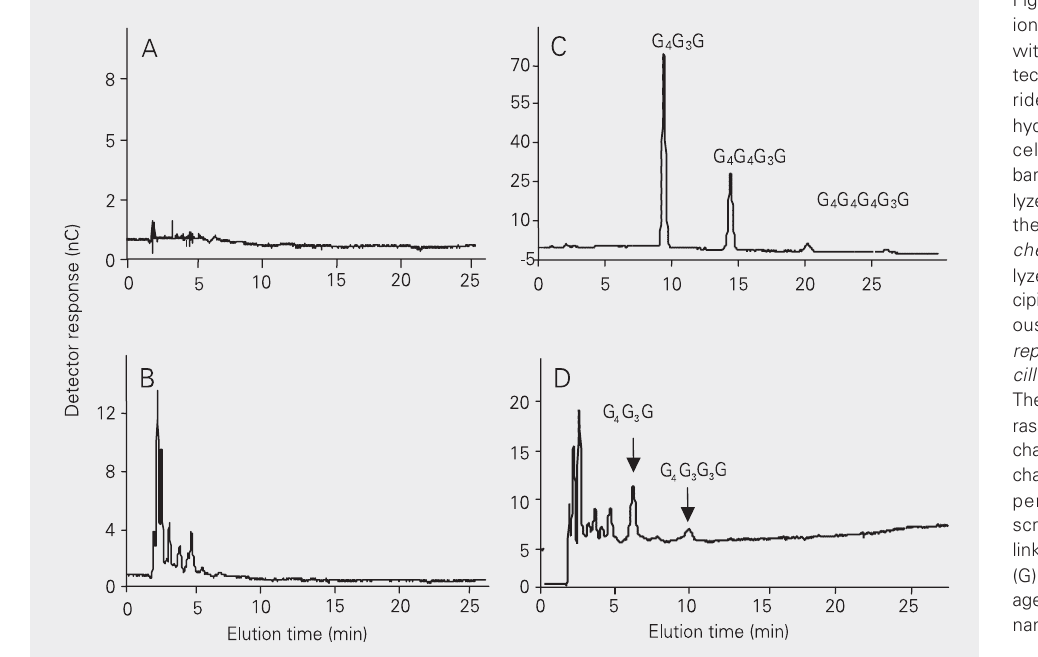
Figure 3. High-performance an- ion exchange chromatography with pulsed amperometric de- tection analysis of oligosaccha- rides produced by enzymatic hydrolysis with Bacillus subtilis cellulase. A , Non-hydrolyzed barley ß-glucan; B , non-hydro- lyzed precipitate obtained from the aqueous extract of Rhyn- chelytrum repens ; C , hydro- lyzed barley ß-glucan; D , pre- cipitate obtained from the aque- ous extract of Rhynchelytrum repens after hydrolysis with Ba- cillus subtilis endo-glucanase. The arrows indicate tri- and tet- rasaccharides. G 4 G 3 G = trisac- charide, G 4 G 4 G 3 G = tetrasac- charide and G 4 G 4 G 4 G 4 G 3 = pentasaccharide. The sub- scripts represent the type of linkage between two glucoses (G): 4 represents a ß-1,4 link- age and 3 a ß-1,3 linkage. nC = nano Columbs.